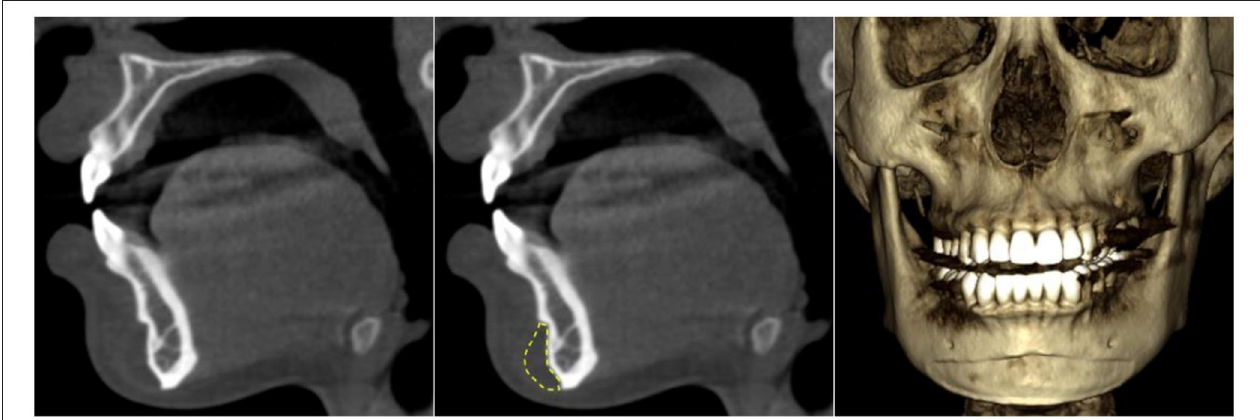
FIGURE 1 | Mandibular bone resorption on the labial surface caused by a chin implant observed with cone-beam CT. The resorption was obvious in both sagittal view and volume rendering. The chin implant is circled